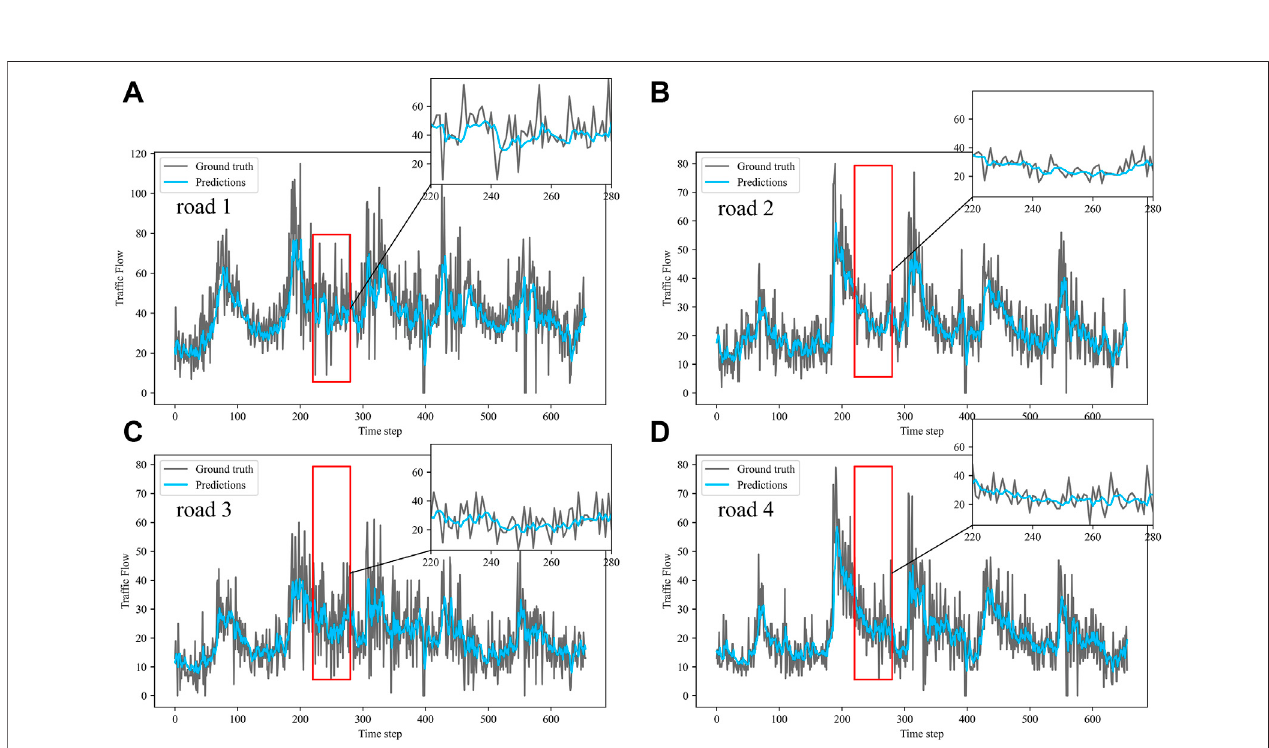
FIGURE 9 | Visualization of GruGcn model prediction results on off-peak dataset. (A) road 1 means Gudun Road (B) road 2 means Fengtan Road. (C) road 3 means Yile Road. (D) road 4 means Jingzhou Road.